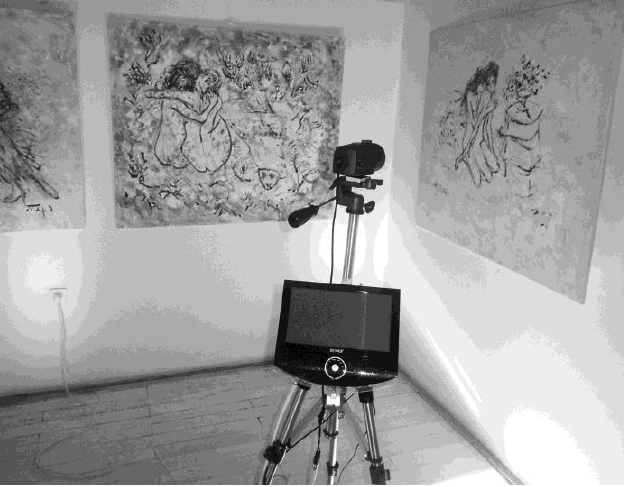
Figure 9. Sveti Ivan Zelina Gallery, acrylic on canvas by the painter Nada Žiljak. View of the exhibition in the NIR-Z spectrum.